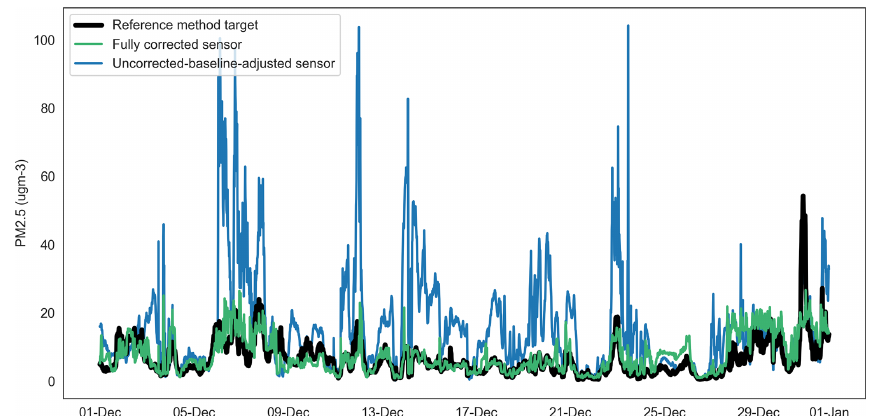
Figure 14. Time series of uncorrected-baseline-adjusted sensor, fully corrected sensor and reference method observations for PM 2 . 5 at Oxford St Ebbe’s (unseen data) for December 2020. ugm-3: µgm − 3